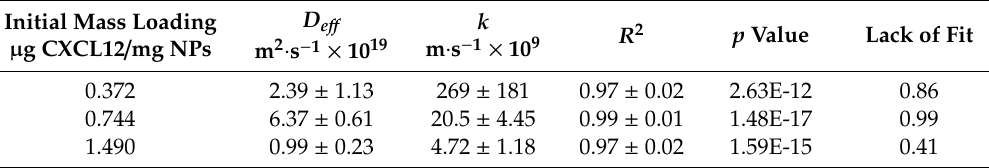
Table 3. Mechanistic parameters estimation and statistics of the mathematical framework ( ±